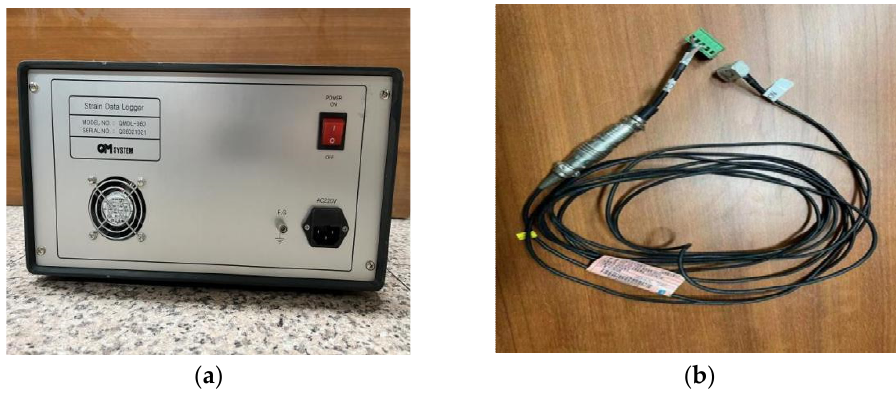
Figure 3. Acceleration capture instrument in this study: ( a ) Data logger; ( b ) Accelerometer. Table 3. Main parameters of accelerometer and data logger.